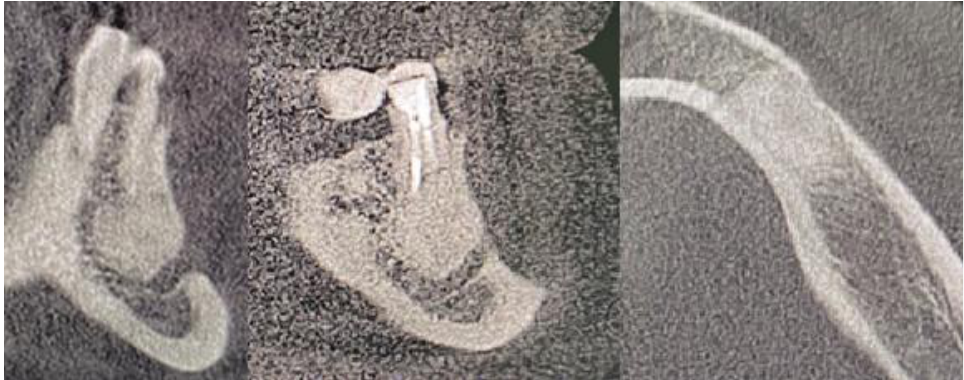
Figure 9. Final view of the operated area after 14 days during suture removal.